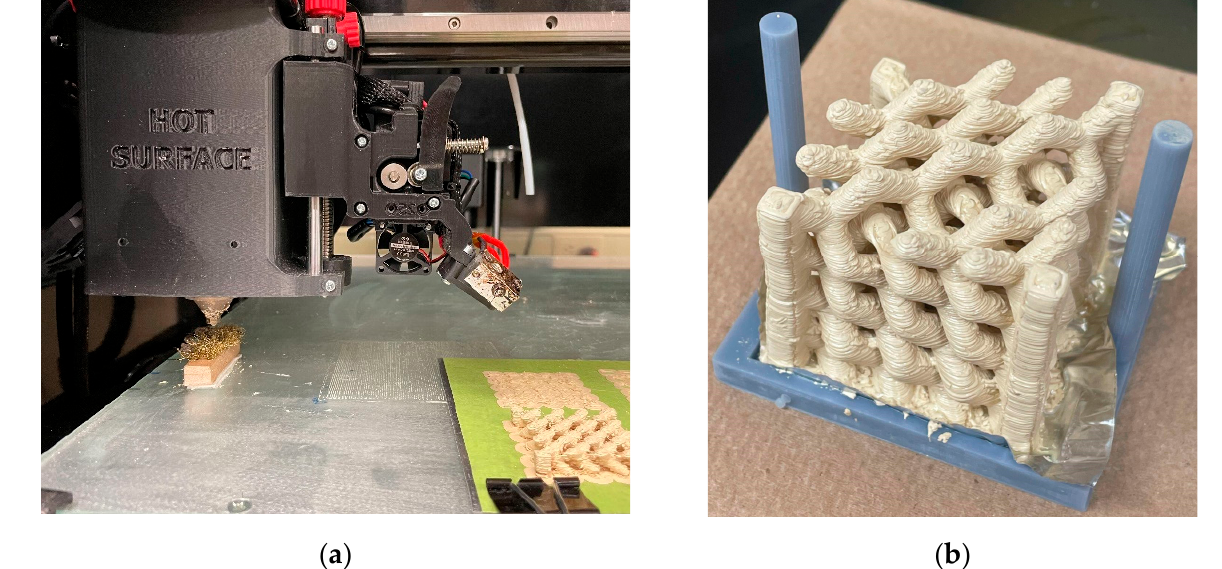
Figure 12. ( a ) Nozzle cleaning system on the printing bed; ( b ) 3D photonic crystal with surface defects removed by immersing in acetone for 30 min.